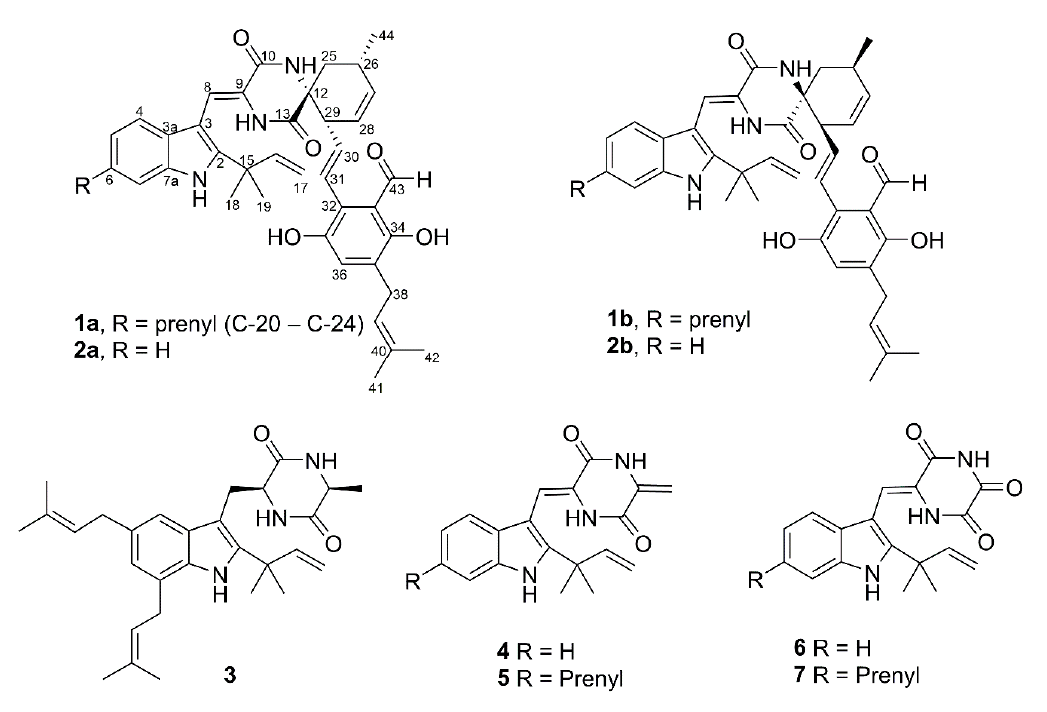
Figure 2. CD curves of 1a (magenta, ■ ) and 1b (blue, ● ). 2.2. Biological Activities of the Isolated Compounds The neuroprotective activities of the compounds in the toxin-induced models of Parkinson’s disease (PD) were investigated in murine malignant Neuro-2a cells because various neuroblastoma cell lines are widely used as in vitro models for Parkinson’s disease (PD) [17–19]. We first evaluated the cytotoxicities of 1 – 7 and found that 1a , 1b , 2 , 3 , 6 , and 7 were noncytotoxic to Neuro-2a cells at concentrations up to 100 µM (Table S1), while 4 and 5 showed moderate cytotoxicities with IC 50 values of 50.9 and 40.6 µM, respectively (Table S1). Note that 4 was reported to be cytotoxic against murine macrophage RAW264.7 cells with a potency similar to that reported here [20]. Our results support the idea that the α , β -unsaturated carbonyl moiety in 4 and 5 control the toxicity of these molecules [21]. Of note, compounds 3 and 7 were moderately cytotoxic